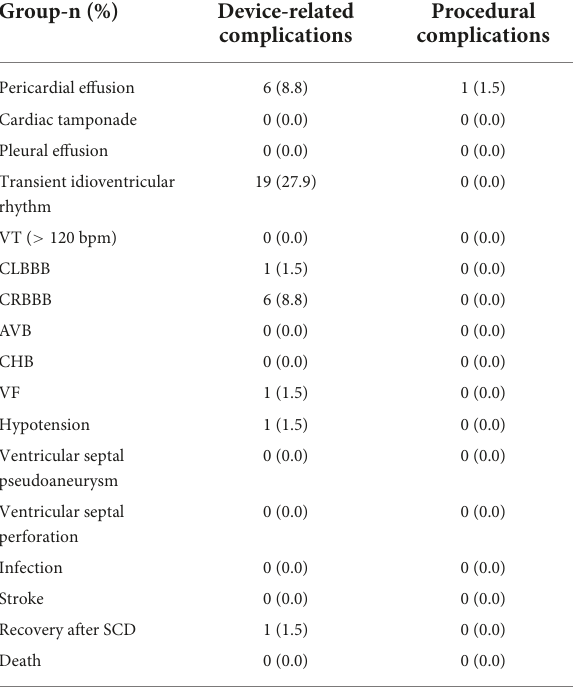
TABLE 4 Major adverse events within 30